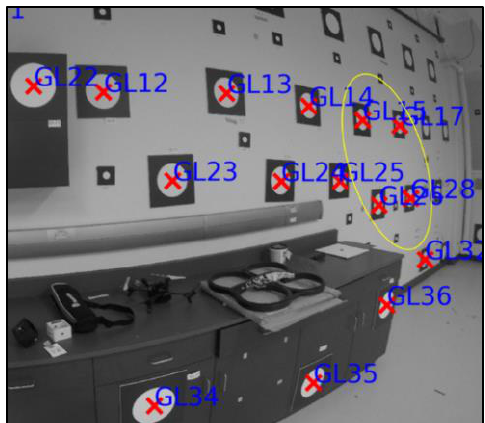
Figure 11. Section of an image from GoPro Hero5, highlighting incorrect labelling caused by radial lens distortion and perspective distortion clustering targets in the